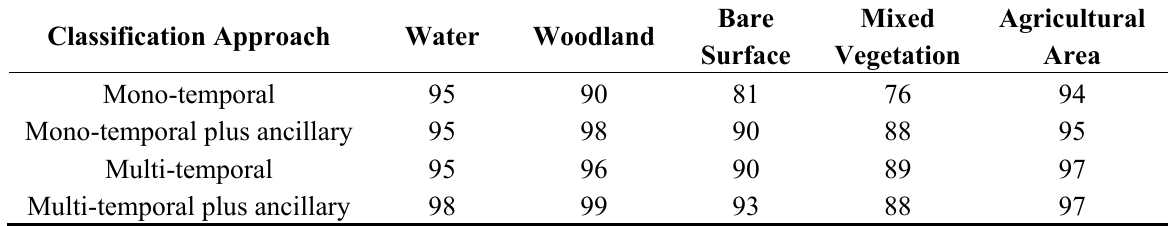
Table 13. LULC user’s accuracy (%) per image combination in 2011.